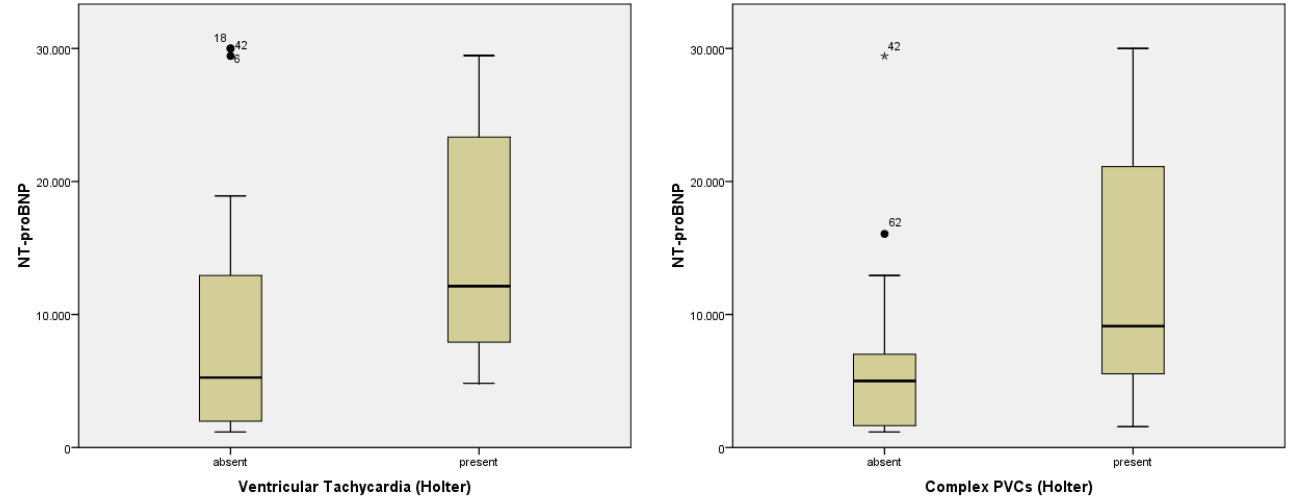
Figure 2. Correlations of NT-proBNP with ventricular tachycardia and complex PVCs in patients with AHF. Abbreviations: NT-proBNP = N-terminal (NT)-pro B-type natriuretic peptide; PVCs = premature ventricular contractions.